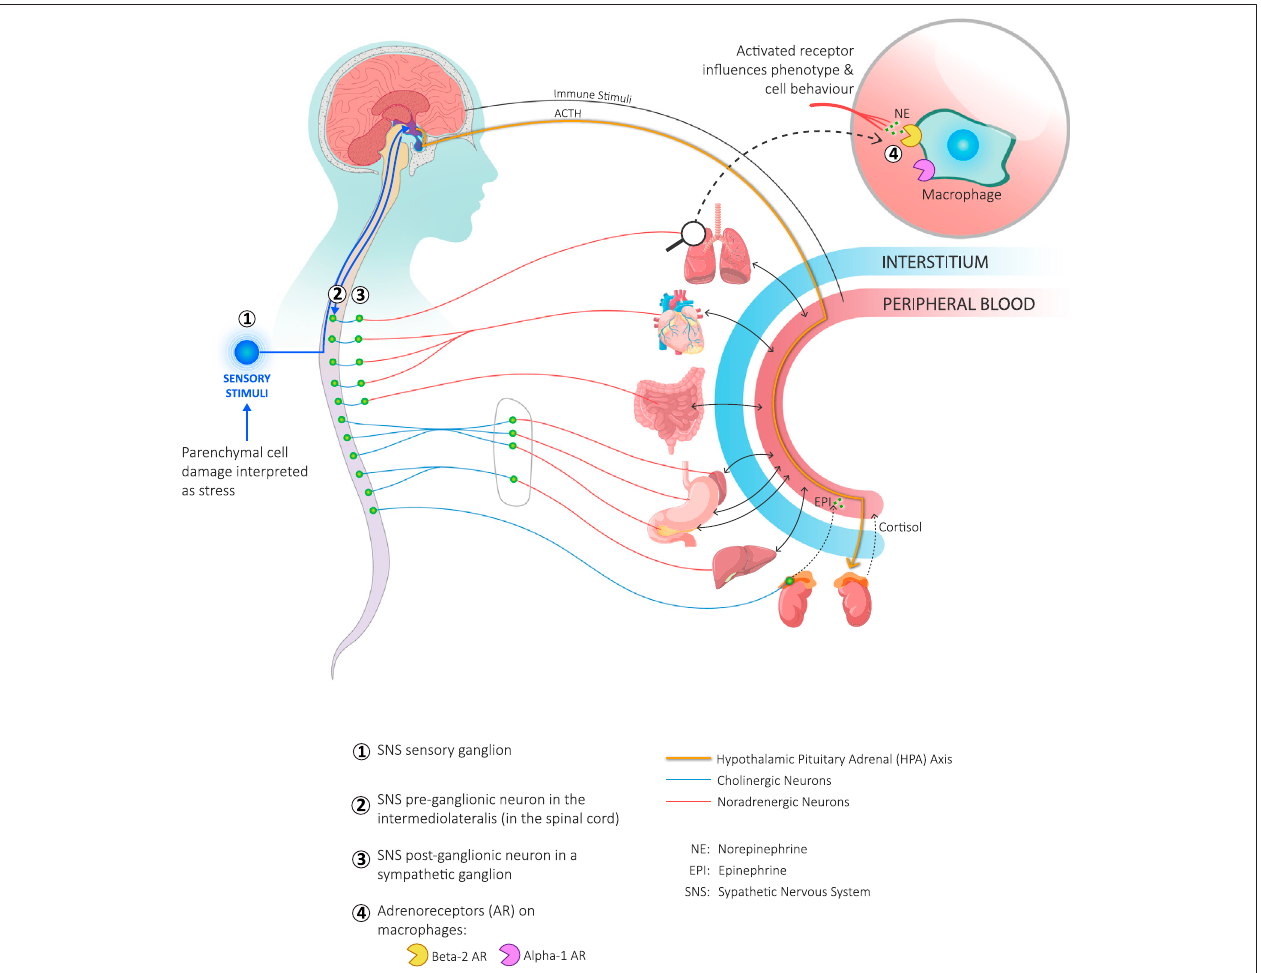
FIGURE 2 | Coordination of the immune and sympathetic nervous systems with the hypothalamic-pituitary-adrenal (HPA) axis in response to parenchymal damage.Localparenchymalcelldamageisinterpretedasathreatbyinterstitialcellsandasstressbysympatheticnerves.Interstitialcellsrespondtothreatsbyreleasing cytokines(notshown).Localsensoryneuronsrespondtostressbyactivatingtheafferentbranchofthesympatheticnervoussystem(SNS)andsendinganimpulsetothe hypothalamus (lower left-hand corner of the fi gure). The hypothalamus responds to the information received from both the circulating cytokines and SNS stimulation (Bellinger and Lorton, 2014) in two ways: it stimulates both the efferent branch of the SNS as well as the HPA axis. Stimulation of the efferent SNS goes through the preganglionic neuron in the intermediolateral nucleus of the spinal cord (green circles). Stimulated preganglionic neurons transmit the signal through a cholinergic axon to post-ganglionic neurons (green circles) and, in a metameric fashion, through a noradrenergic axon to the affected organ where norepinephrine is released. A preganglionic neuron may also transmit directly to chromaf fi n cells in the adrenal medulla which in turn stimulates the release of epinephrine directly into the bloodstream.WhentheHPAaxisisstimulated,thehypothalamusreleasescorticotropinreleasinghormonethatstimulatesthereleaseofadrenocorticotrophichormone (ACTH) from the anterior pituitary. ACTH binds to receptors on the adrenal cortex and stimulates the release of cortisol into the blood stream. Both epinephrine and norepinephrineinteractwithadrenergicreceptorsonimmunecells,includingmacrophages(upperright-handcornerofthe fi gure).Thisactivatessignallingpathwaysthat constitutes one of the in fl uences on the phenotype and behaviour of